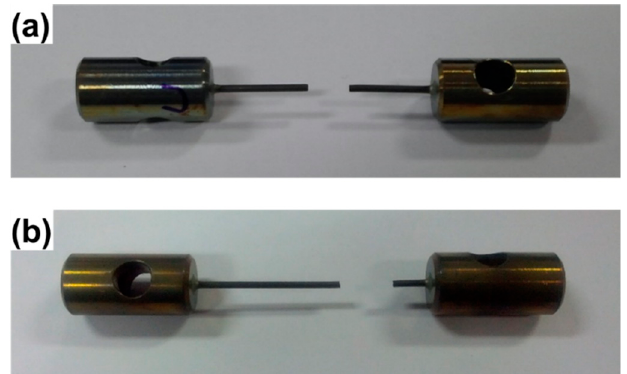
Figure 10. ( a ) Short-life (78,621 cycles) and ( b ) long-life (781,887 cycles) tube specimens at 1000 K and σ max = 402 MPa.